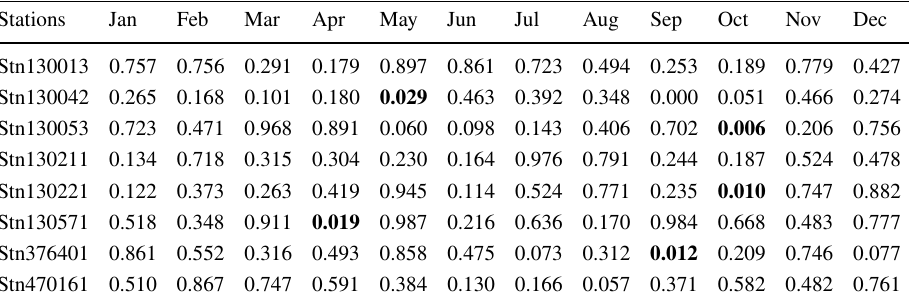
Bold number represents p < 0.05 indicating inhomogeneity in the corresponding time series at a 5% signifi-